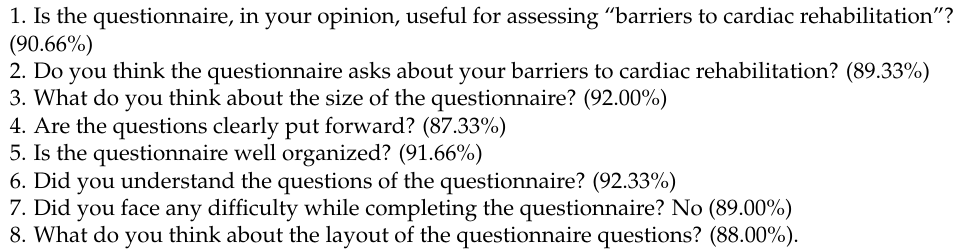
Table 1. Results from the subjective evaluation * of the CRBS-GR, N =